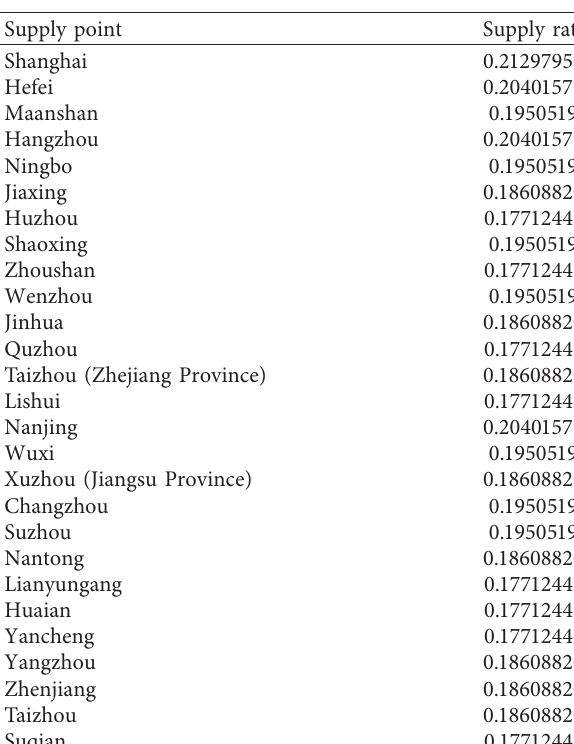
Table 5: Proportion of kitchen waste supply points in the Yangtze River